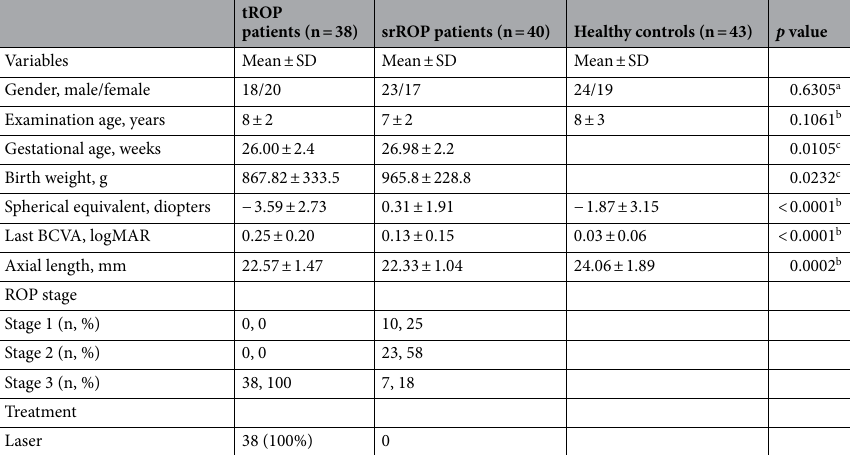
Table 1. Characteristics of preterm patients with a history of retinopathy of prematurity with treatment, spontaneously regressed, and full-term healthy controls. ROP, retinopathy of prematurity with laser treatment; srROP, spontaneously regressed retinopathy of prematurity; SD, standard deviation; BCVA, best-corrected visual acuity. a Chi-square test. b Kruskal–Wallis test. c Wilcoxon rank sum